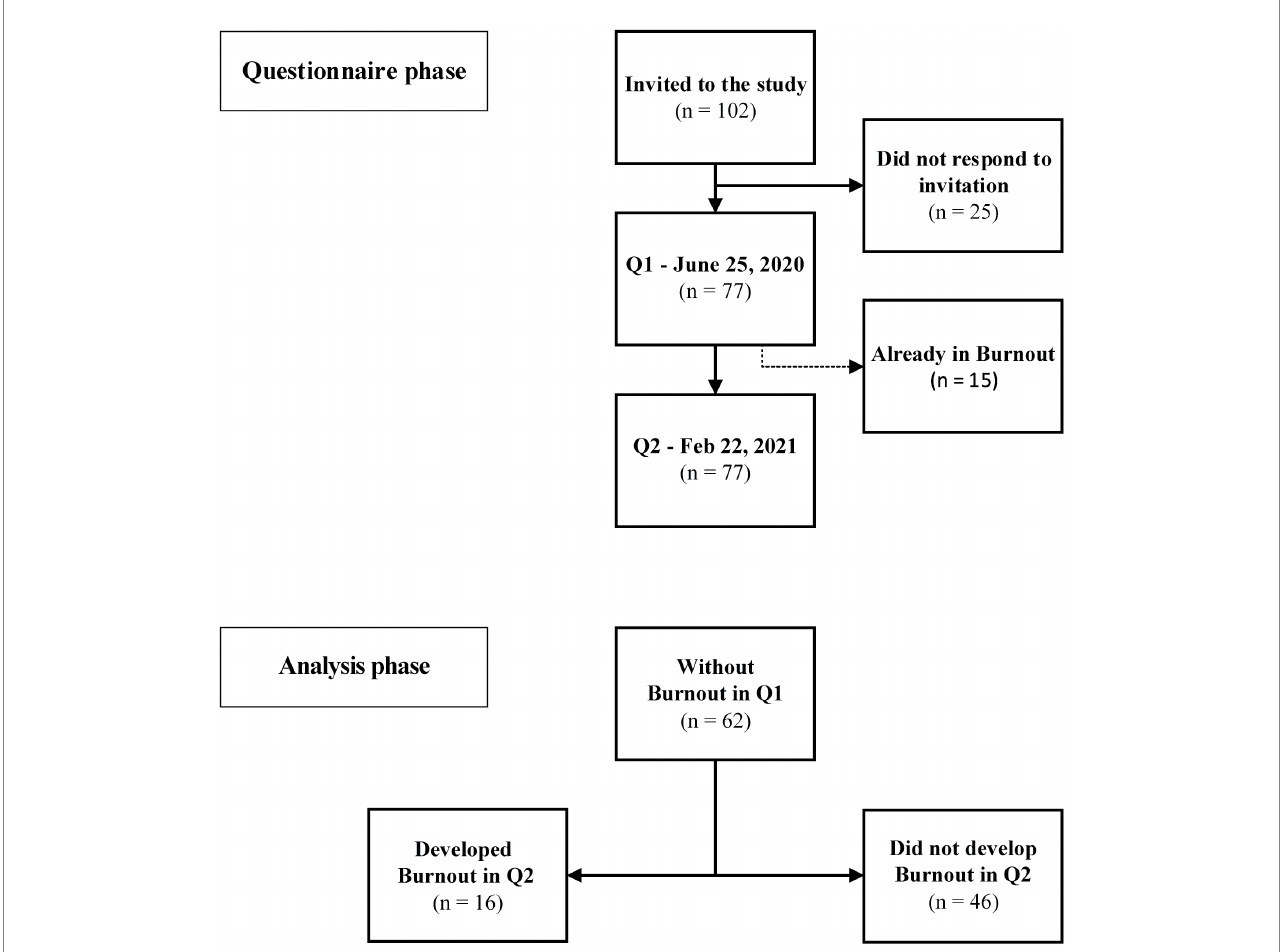
FIGURE 1 Study flowchart. The questionnaires phase demonstrates the time-points in which they were applied. There was no loss of follow-up between study periods. The analytical phase included only health professionals who did not have burnout in